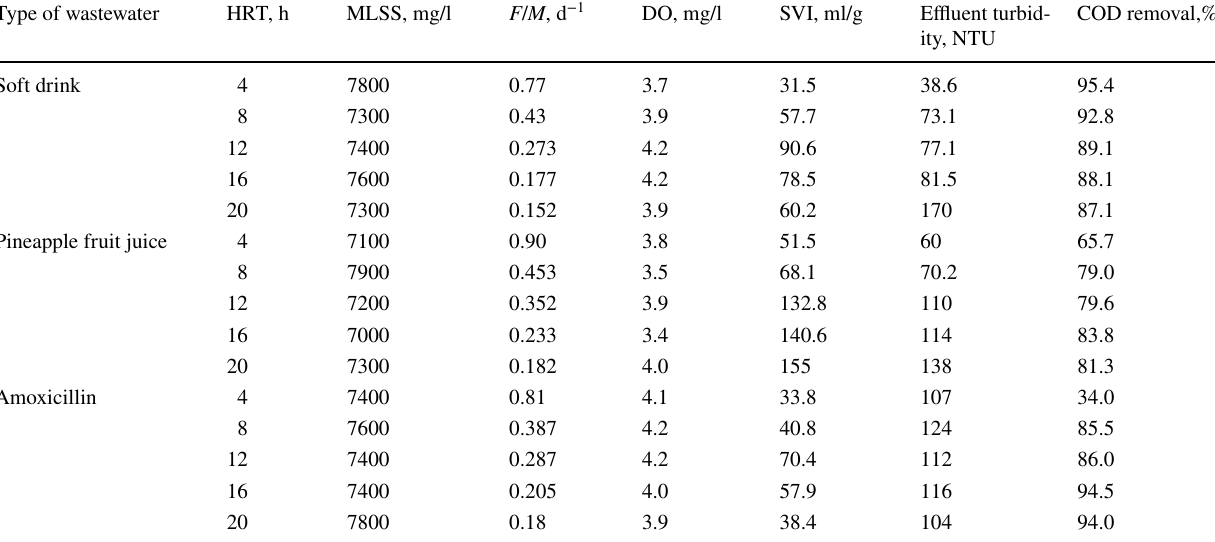
Table 3 The operating conditions and the results obtained for treating different wastewaters Type of wastewater HRT, h MLSS, mg/l F / M , d −1 Soft drink